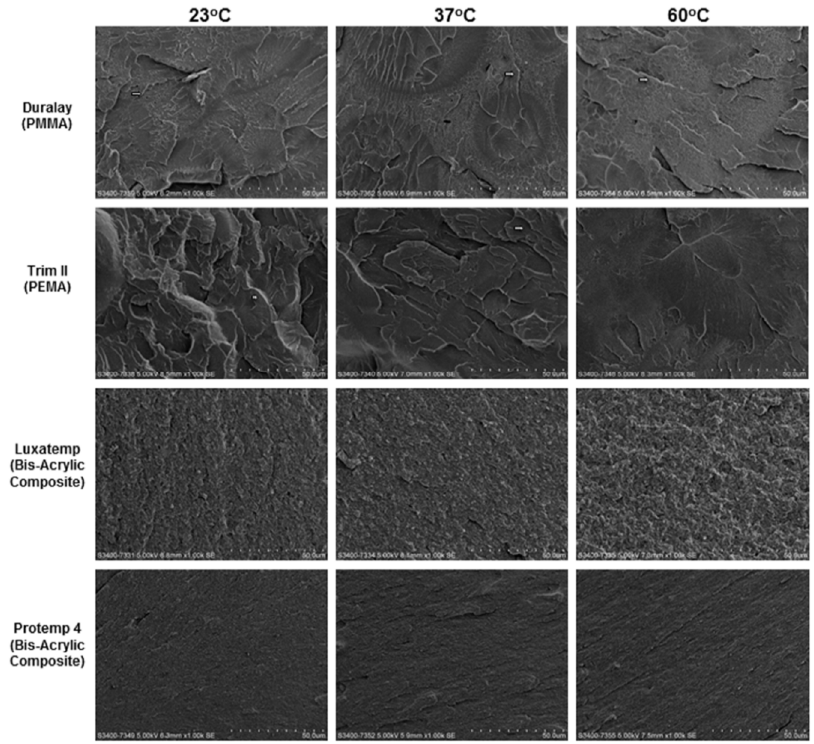
Figure 2. SEM images of fractured surfaces of the materials (×1000). Scale bar: 50